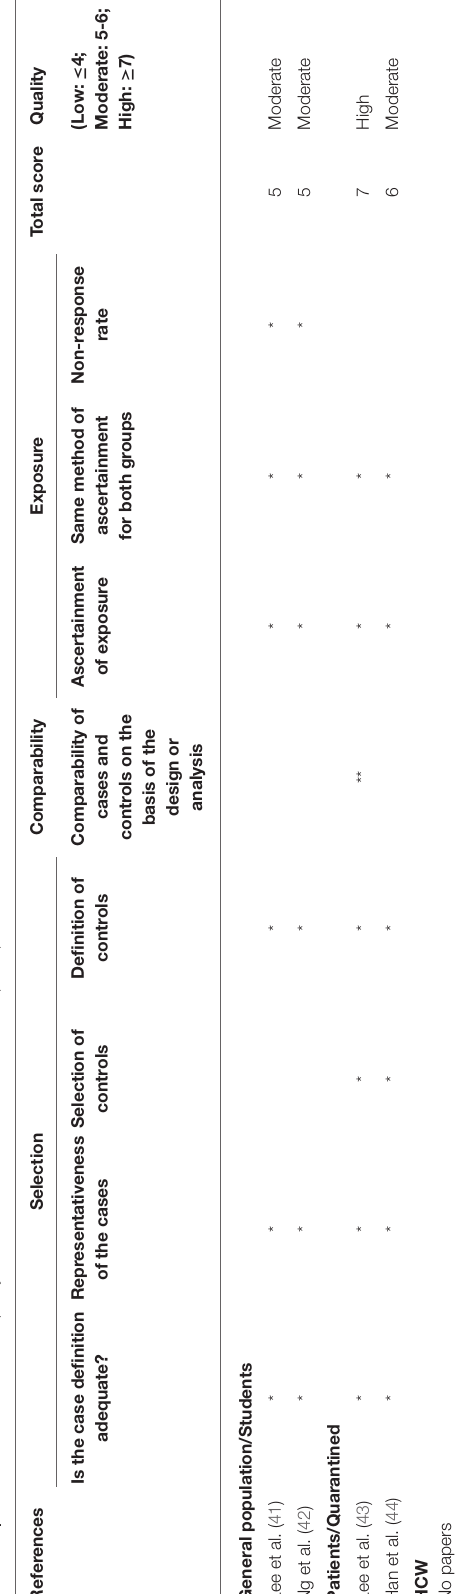
(2.24 ± 0.56, p = 0.483 on a four-point Likert scale) in a sampled group of 82 healthcare workers (81). The correlation